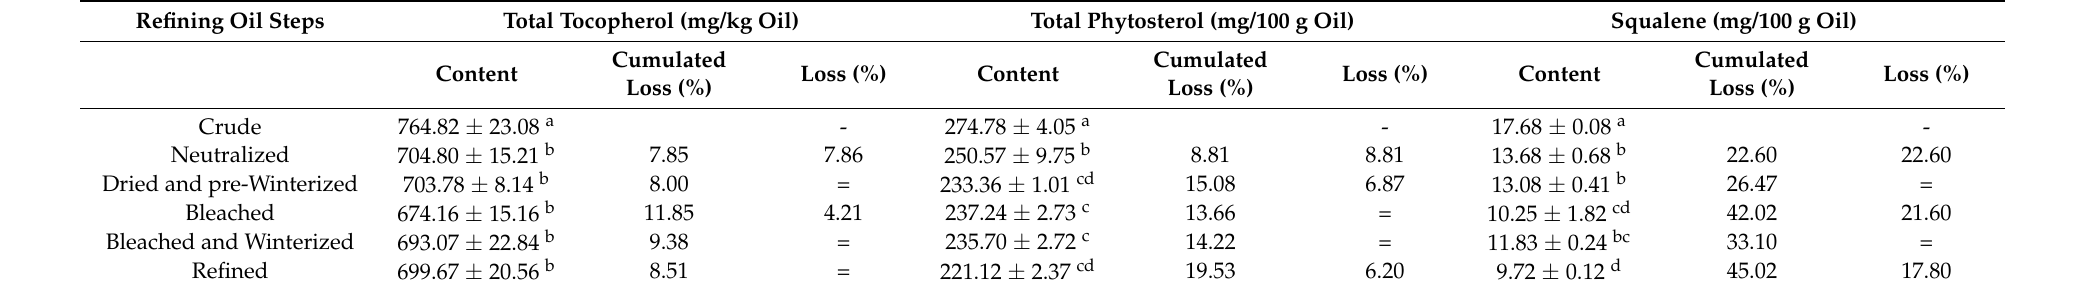
Table 3. Content of tocopherol, phytosterol and squalene (Mean ± Standard deviation) and their losses found at each step of the refining process for the two types of samples, solvent-extracted oil and cold-pressed